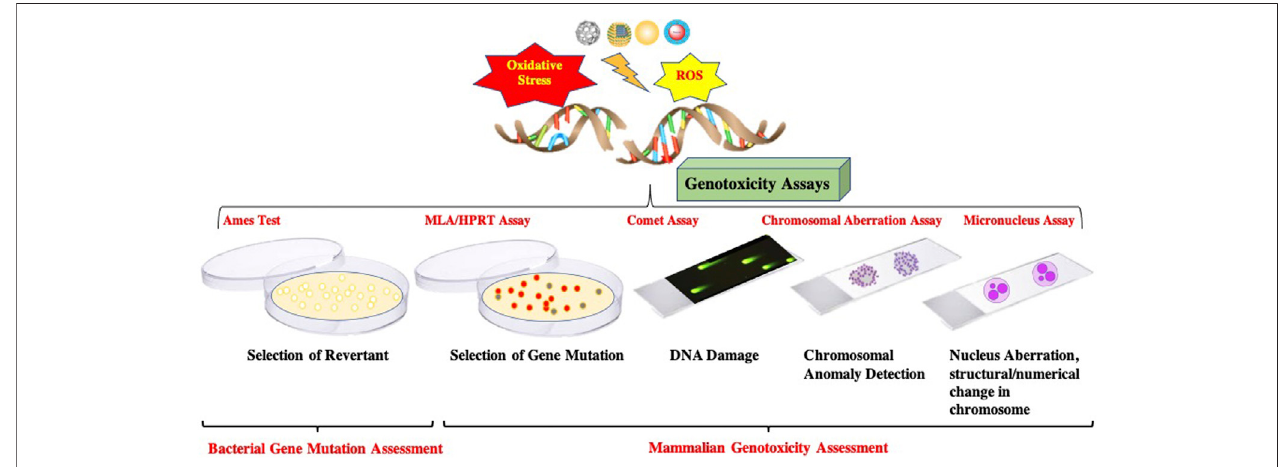
FIGURE 2 | Schematic representation of standard battery of Genotoxicity